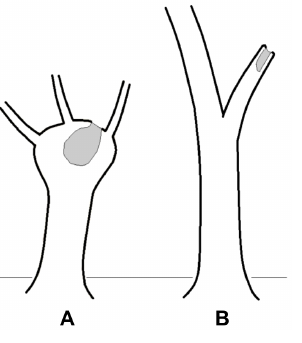
Figure 1. Forms of pollard and unmanaged trees. A pollard (A) and an unmanaged tree (B), shown with their most common type of tree hollows (grey colored): hollows formed in the upper parts of the trunk as a result of bared heartwood after pruning are common in pollards, whereas hollows formed after a branch fall are the most common hollow type in unmanaged